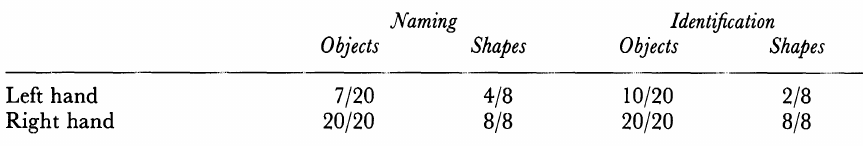
Left hand Right